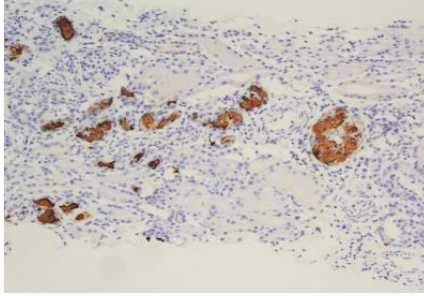
Figure 3: Tubular casts are positive for myoglobin